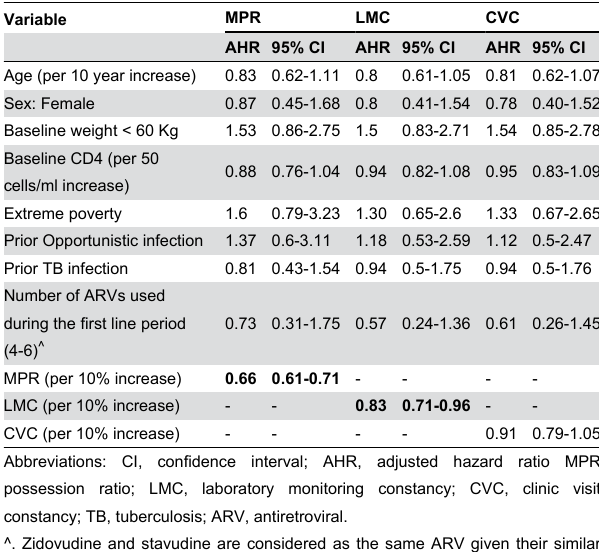
Table 1. Baseline characteristics of antiretroviral-naive patients starting initial ART regimens and patients switching to a second line regimen at Hospital Nacional Cayetano Heredia in Lima, Peru; January 2, 2006-December 30, 2010.